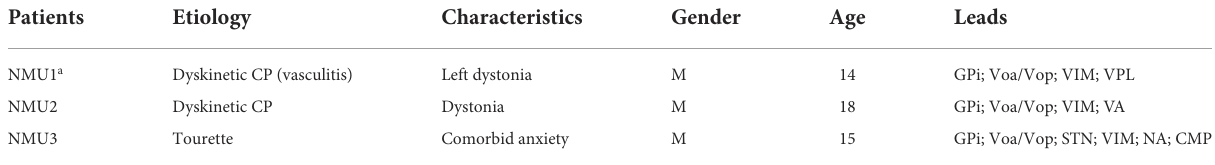
TABLE 1 Demographic